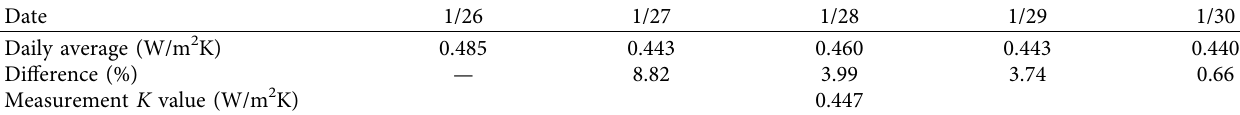
Table 3: Comparison of the daily average K values.